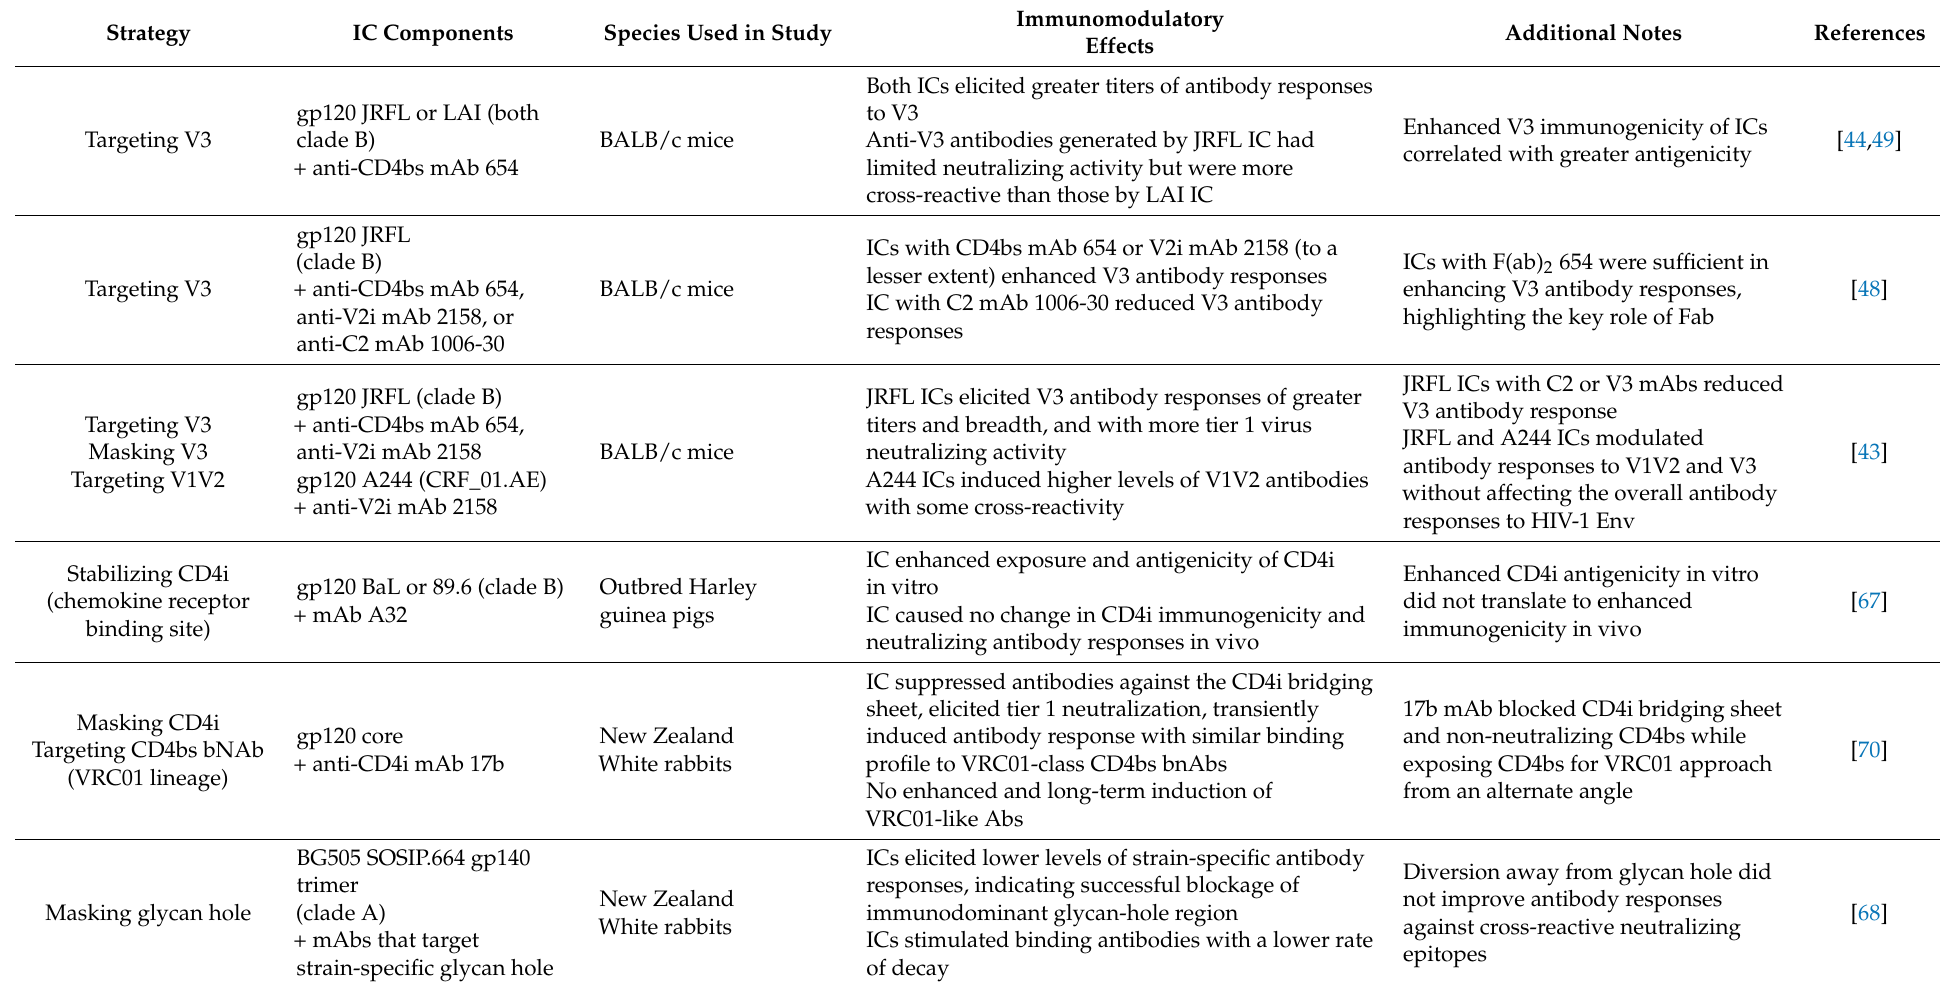
Table 2. Immune complex (IC) vaccines against